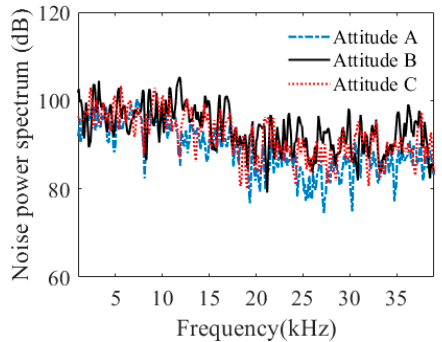
Figure 9. Flow noise power spectrum at the stagnation point of the axisymmetric body in di ff erent attitudes.